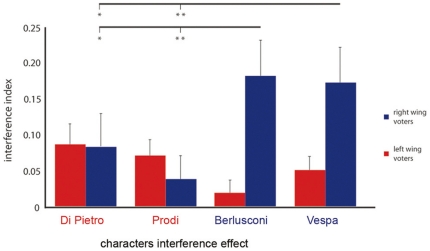
Interaction between participants political affiliation and characters interference effect.Influence of the political characters' gaze on the voters' oculomotor response. On the y axis is represented the interference index, deducted by the difference between the accuracy (percentage of correct responses) in congruent minus incongruent trials. Error bars represent Standard errors of mean (SEM). We reported significance (* = p <.05, ** = p<.01) only for the post-hoc comparisons between the characters' interference effect within the groups.